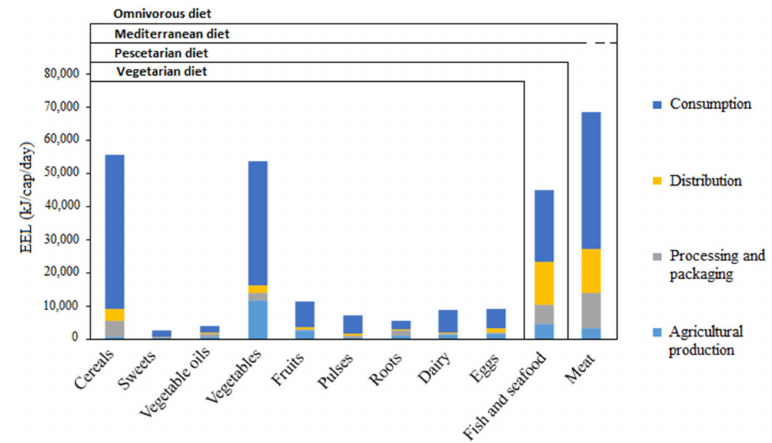
Figure 7. Embodied energy loss (EEL) of the different food categories throughout the supply chain. Values expressed in kilojoules per capita per day.